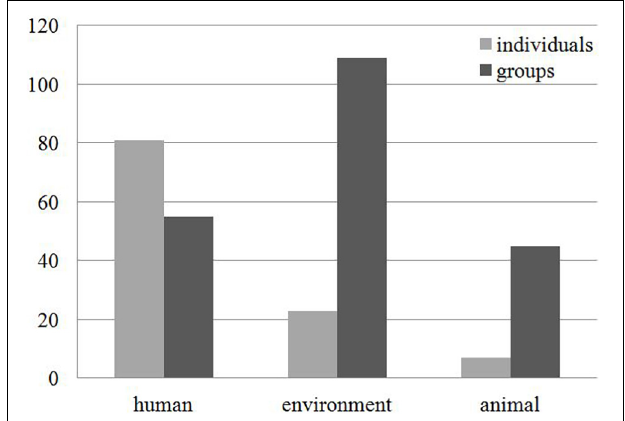
FIGURE 1 | Frequency of actions proposed individually and in groups by preservice teachers to avoid future pandemics, by the corresponding One Health